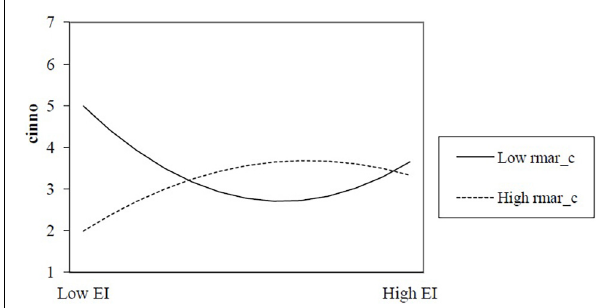
FIGURE 2 | Reversal mechanism of institutional development